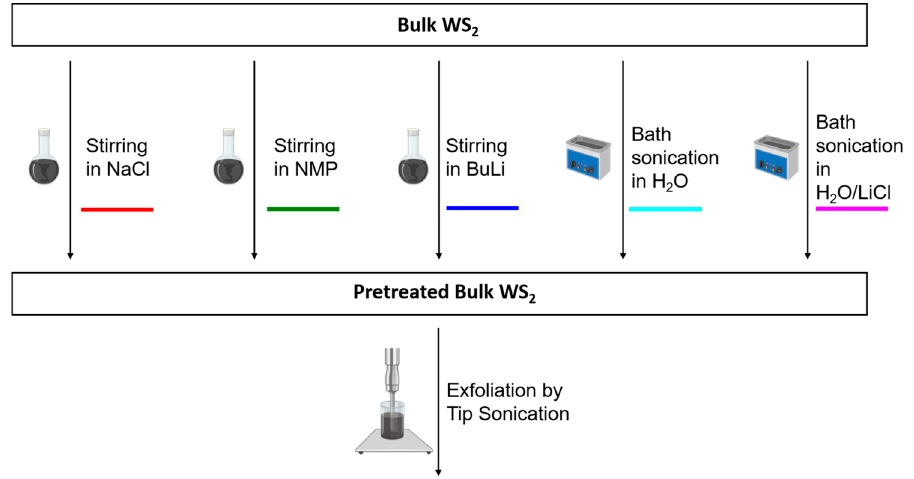
Figure 1. Pretreatment scheme of WS 2 . Bulk WS 2 was subjected to 5 different pretreatments prior to exfoliation, including stirring in NMP, stirring in aqueous NaCl solution, stirring in hexane/BuLi, bath sonication in water and bath sonication in an aqueous LiCl solution. For the ease of characterization, we subjected the stock dispersions to liquid cascade centrifugation (LCC) for size selection in analogy to previous reported procedures [31]. In LCC, a dispersion is successively centrifuged with increasing centrifugal accelerations (ex ‐